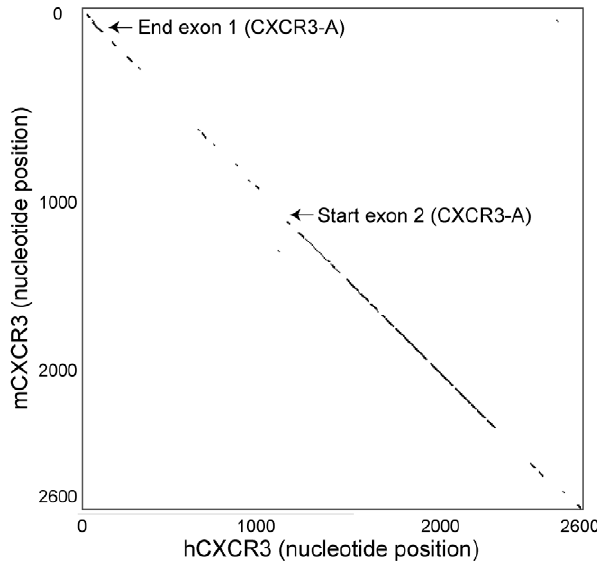
Figure 4. Homology of human and murine CXCR3 gene is confined to CXCR3-A coding regions. A dot matrix of the human CXCR3 and the murine CXCR3 gene was generated with the Dnadot software (http://arbl.cvmbs.colostate.edu/molkit/dnadot/), with a win- dow size of 21 and a mismatch allowance of 3.